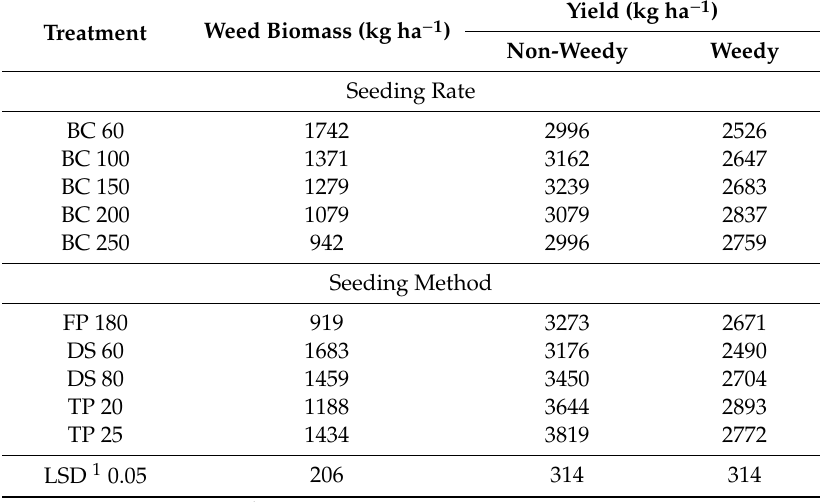
Table 5. E ff ect of seeding method and rate on weed biomass and paddy yield (t ha − 1 ). Yield (kg ha − 1 ) Treatment Weed Biomass (kg ha − 1 ) Non-Weedy Weedy Seeding Rate BC 60